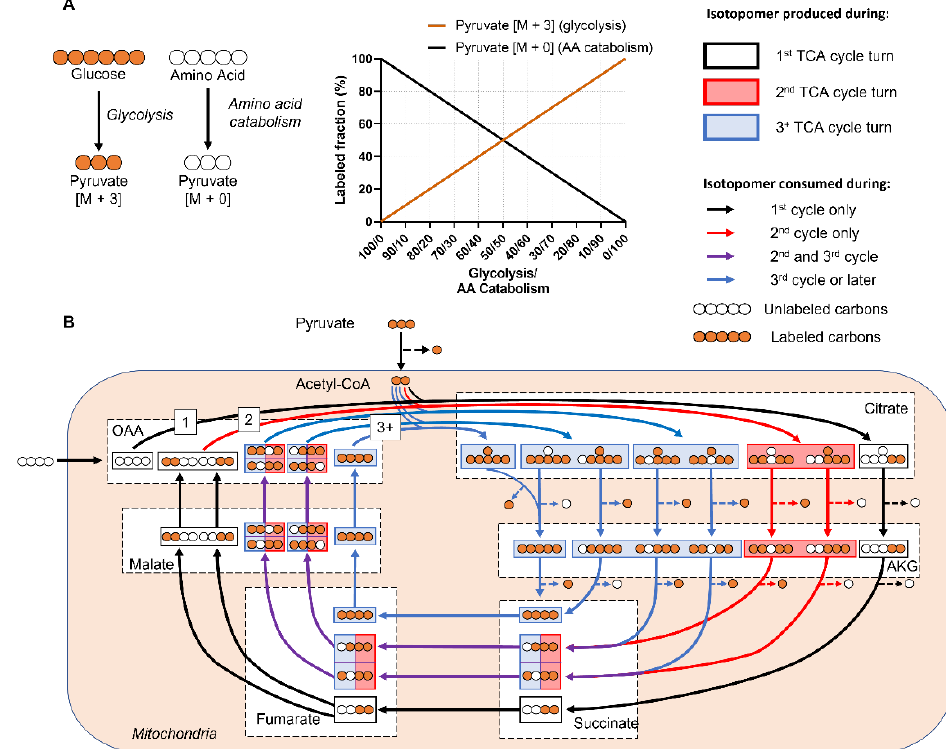
Figure 1. Labeling patterns from mammalian metabolic networks are complex and difficult to interpret. ( A ) A simple metabolic network that assumes only two sources for pyruvate: labeled glucose and unlabeled amino acids. The relative fraction of [M+3]/[M+0] pyruvate isotopomers depends on relative activity of glycolysis vs. amino acid catabolism. As glycolytic activity increases, more of the pyruvate pool will be labeled. ( B ) Cyclic metabolic networks, such as the TCA cycle, generate a different set of isotopomers at each turn. This simplified example assumes a TCA cycle in which uniformly labeled glucose and an unlabeled 4-carbon substrate that feeds into oxaloacetate (OAA) are the only carbon contributors. Each color represents a different turn of the TCA cycle. The anaplerotic source forms the initial OAA backbone that is metabolized with glucose-derived labeled acetyl-CoA to form [M + 2] citrate (black arrows). Fumarate and succinate are symmetrical molecules, means the labeled atoms can flip positions. This doubles the number of malate isotopomers generated from partially labeled fumarate (purple arrows) starting from the 2nd turn of the TCA cycle, which ultimately results in additional citrate isotopomers in the subsequent turns of the TCA cycle (blue arrows). Real world examples in which multiple anaplerotic pathways feed into the TCA cycle, as well as reversible reactions, add more complexities. Abbreviations: Citrate (Cit), Alpha-ketoglutarate (AKG), Oxaloacetate (OAA), Fructose-6-phosphate (F6P), Glucose-6-phosphate (G6P), Amino Acid (AA).